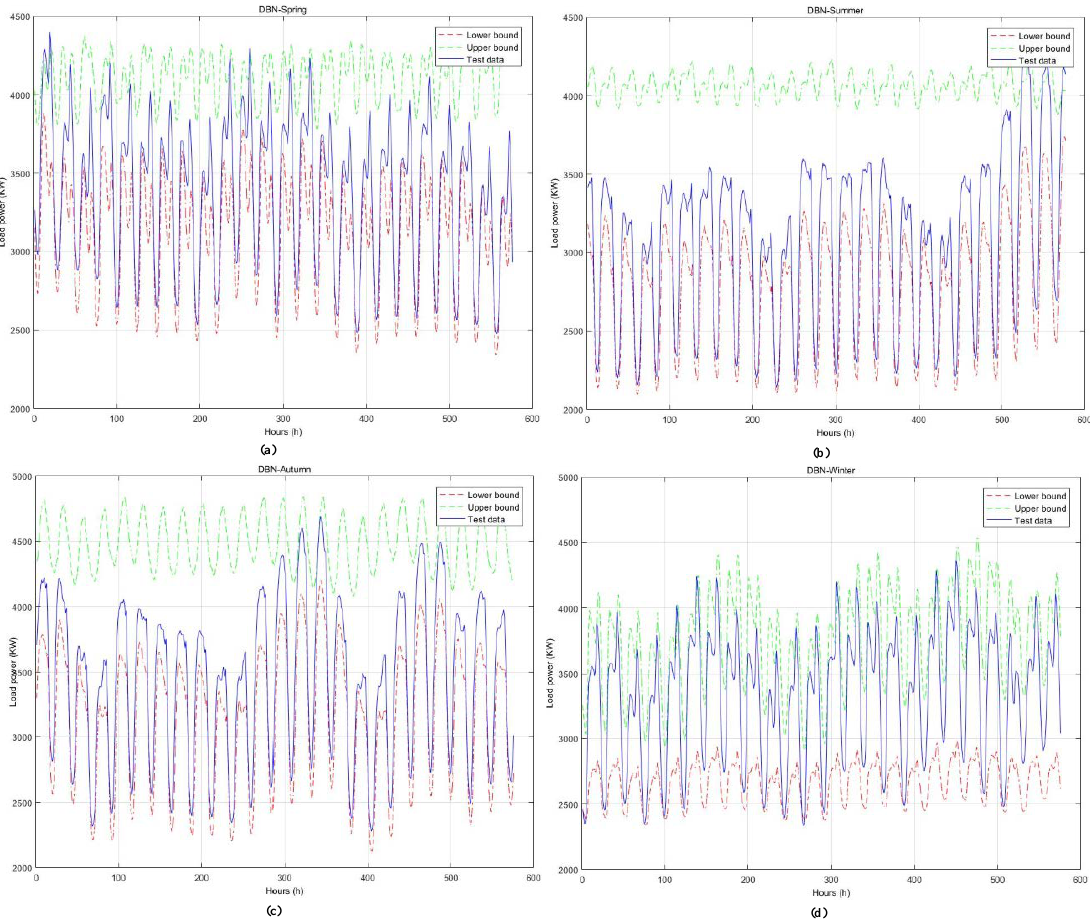
Figure 12. The construction PIs of four seasons by the DBN neural network: ( a ) The prediction results for spring; ( b ) the prediction results for summer; ( c ) the prediction results for autumn; ( d ) the prediction results for winter. Table 4. Prediction results on four seasons.